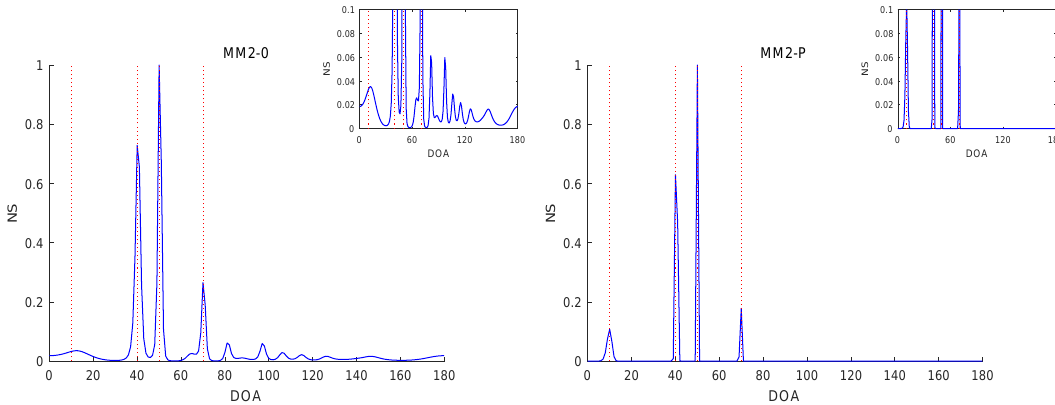
Figure 8. NSs of Experiment 2 with n = 100, SNR = 0 dB and ∆ ξ = 3 ◦ .